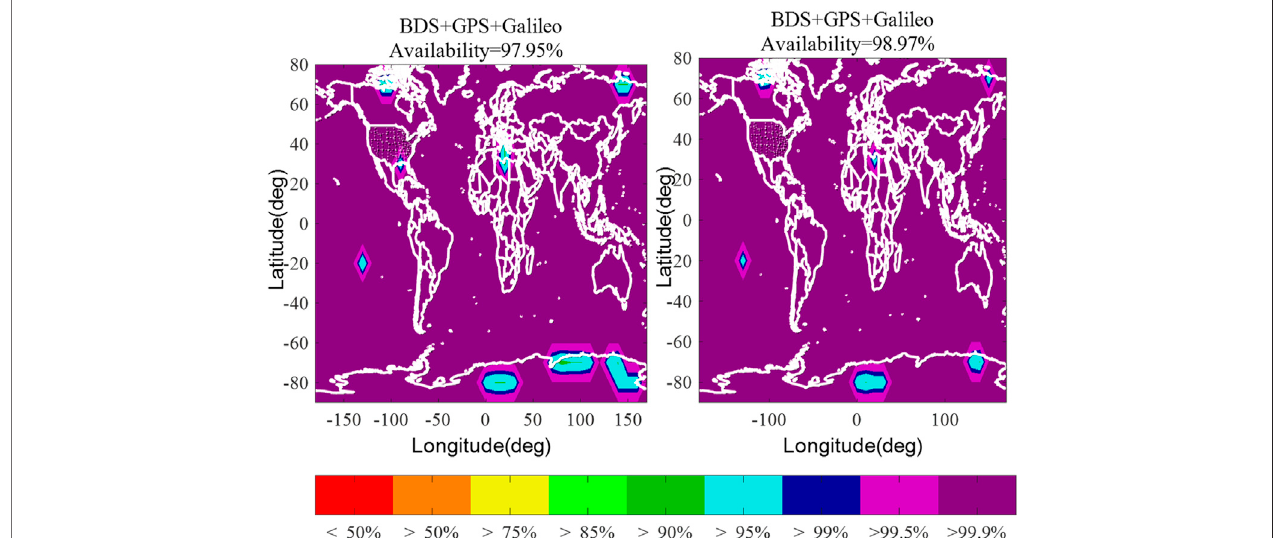
FIGURE 7 | Availability before and after three-constellation optimization under the condition of VAL = 35 m.